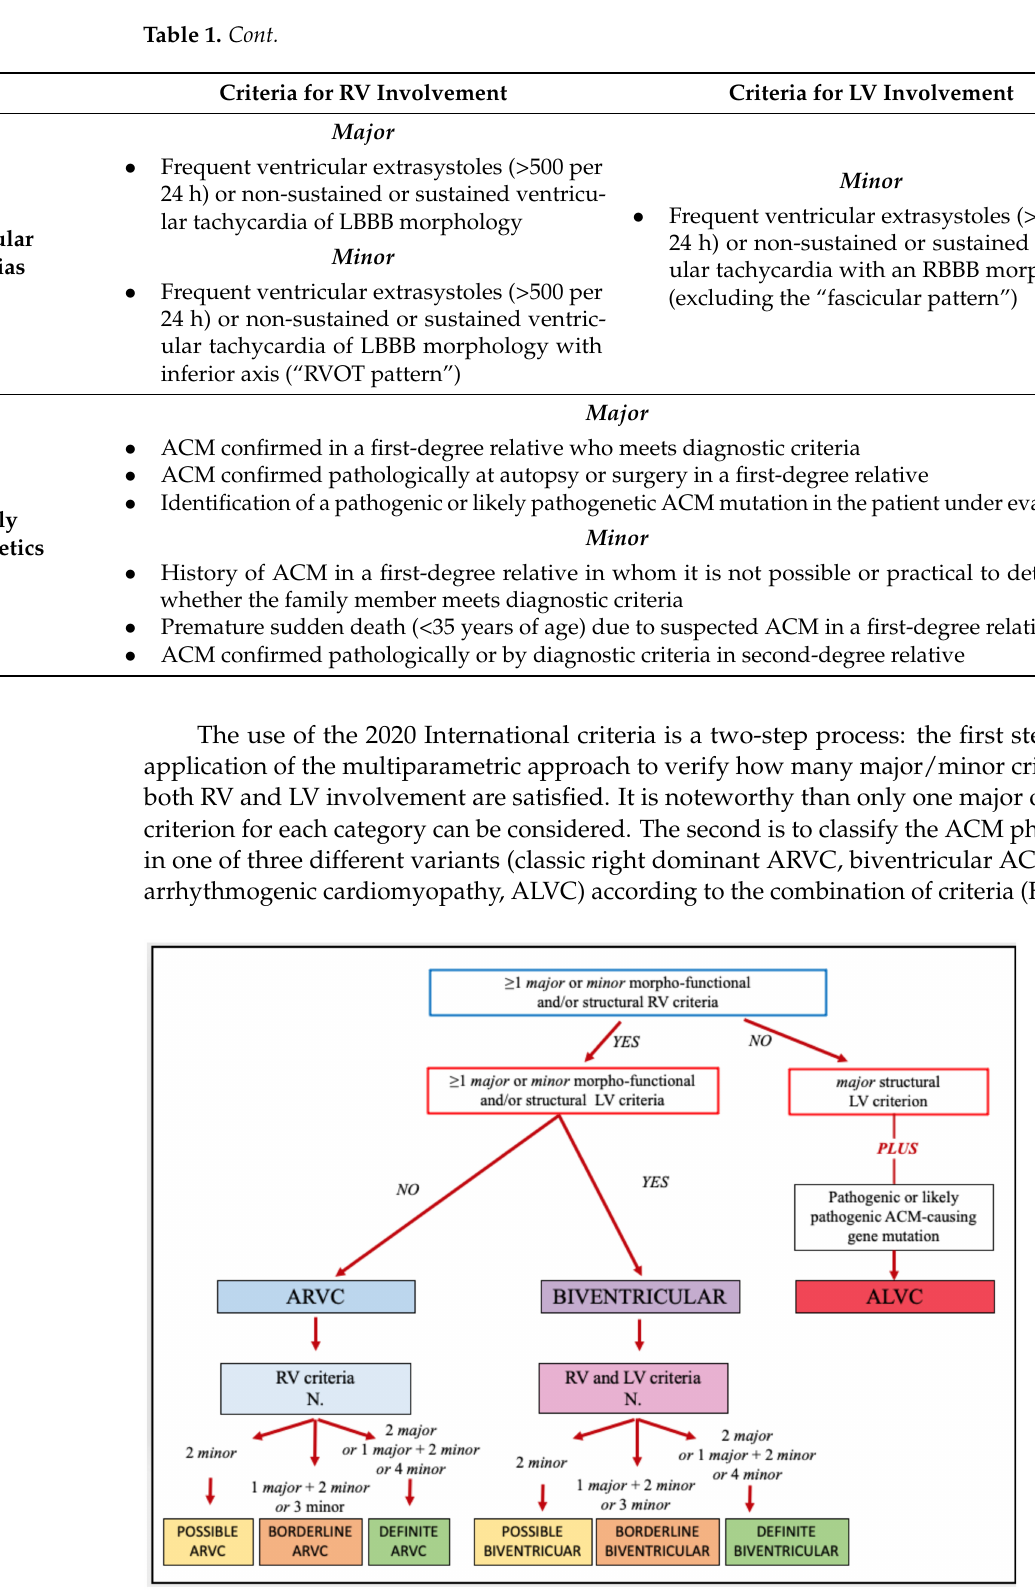
Figure 1. Flowchart for phenotypic characterization of arrhythmogenic cardiomyopathy